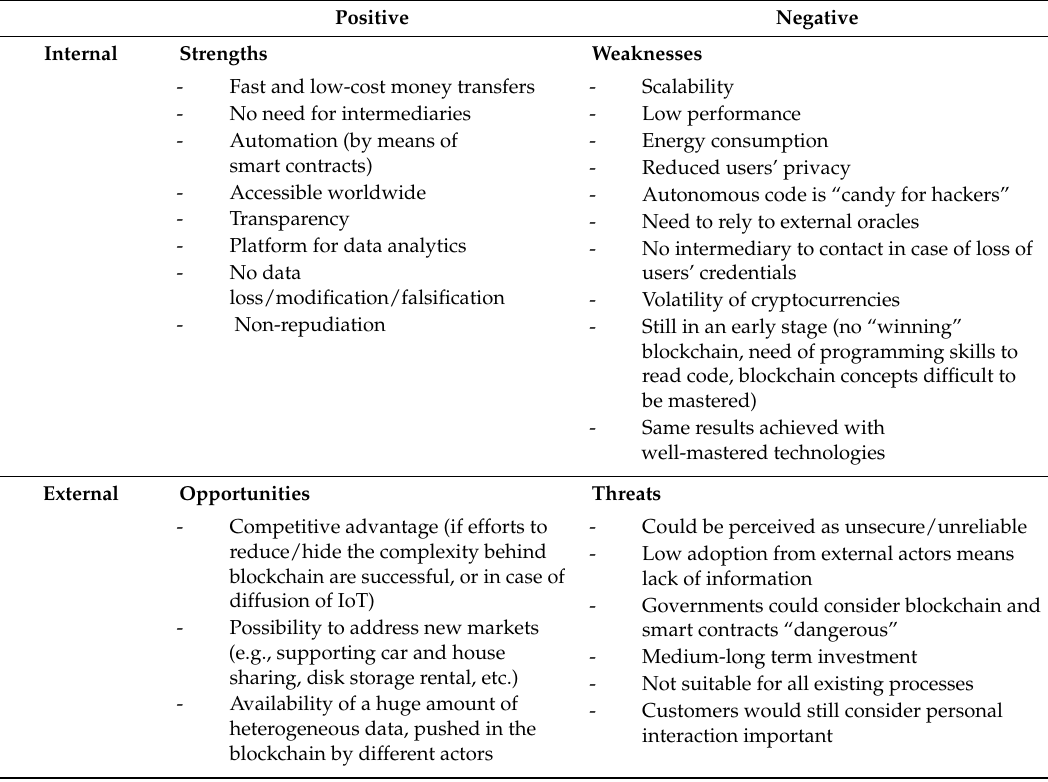
Table 1. SWOT analysis of the adoption of